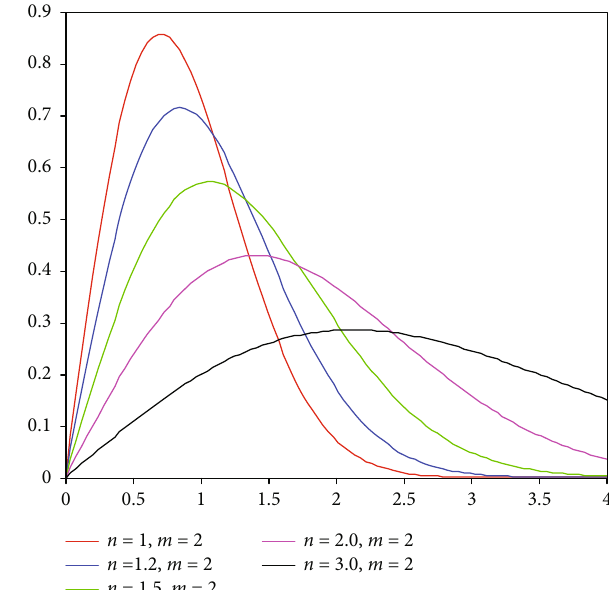
Figure 2: Weibull probability density function when m is 2 and n are 1, 1.2, 1.5, 2.0, and 3.0.